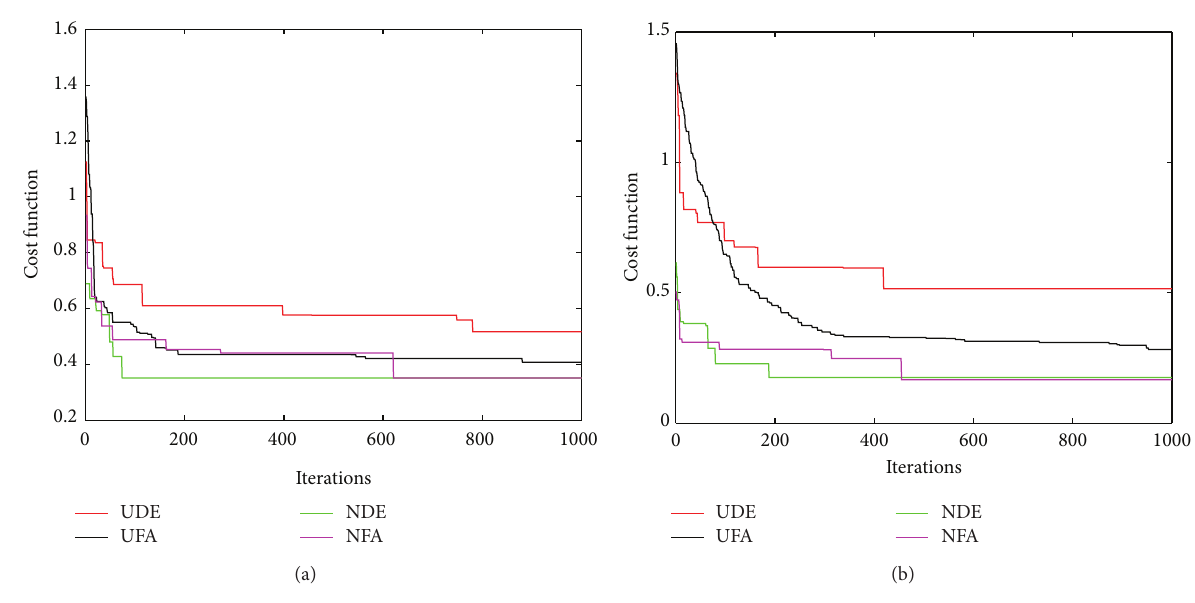
Figure 6: Fitness curves for (a) 𝑁 × 𝑀 = 5 × 5 , (b) 𝑁 × 𝑀 = 7 × 7